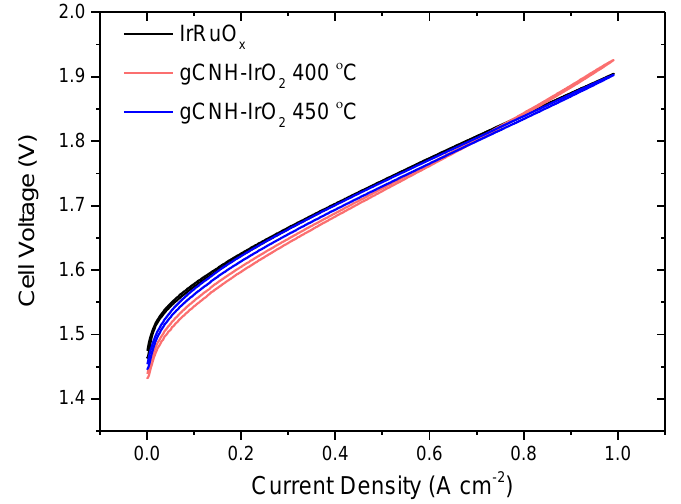
Figure 7. Polarization measurements of PEMWEs with MEAs containing anodes made from ( a ) IrO 2 , ( b ) gCNH-IrO 2 prepared at 400 °C, and ( c ) gCNH-IrO 2 prepared at 450 °C. Measurements conducted at 80 °C and atmospheric pressure.